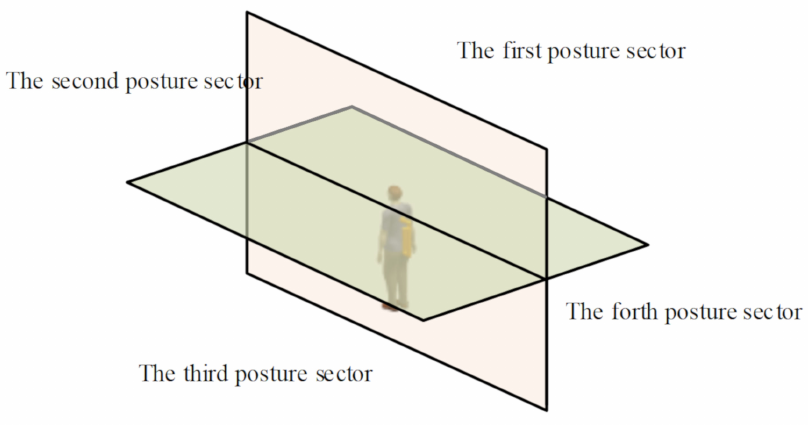
Figure 8. Posture sectors division.